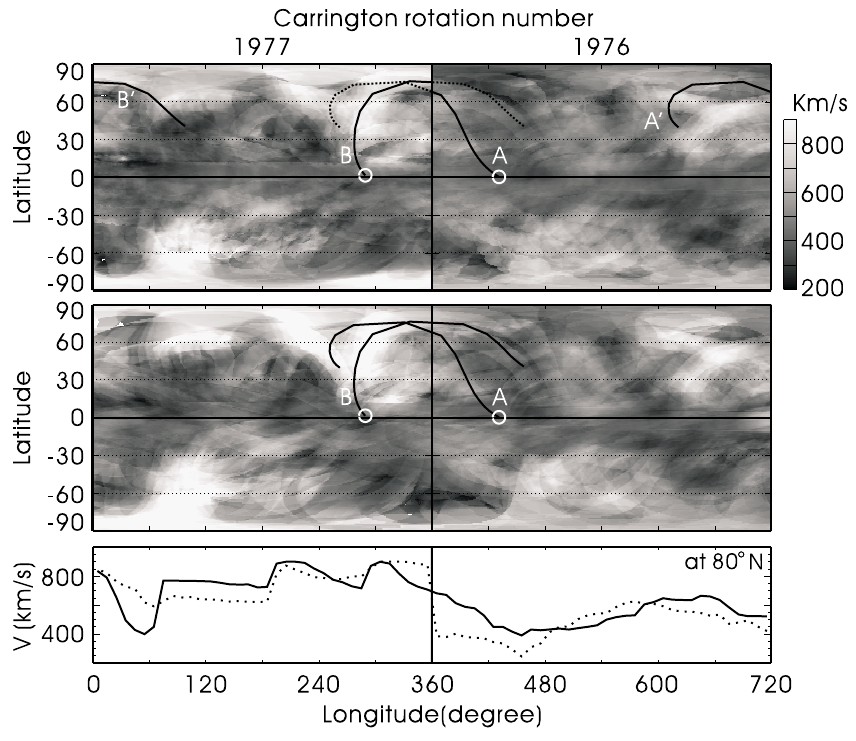
Fig. 1. Typical example of the difference between original CAT and TST. Solid curve in top and middle panels are the line-of-sight of 3C119 observed in DOY 152 ( a ) and DOY 162 ( b ) , respectively. White circles represent the position of the Earth each day. Longitudinal velocity profiles of original CAT (dotted) and TST (solid) at 80 ◦ N are plotted in bottom